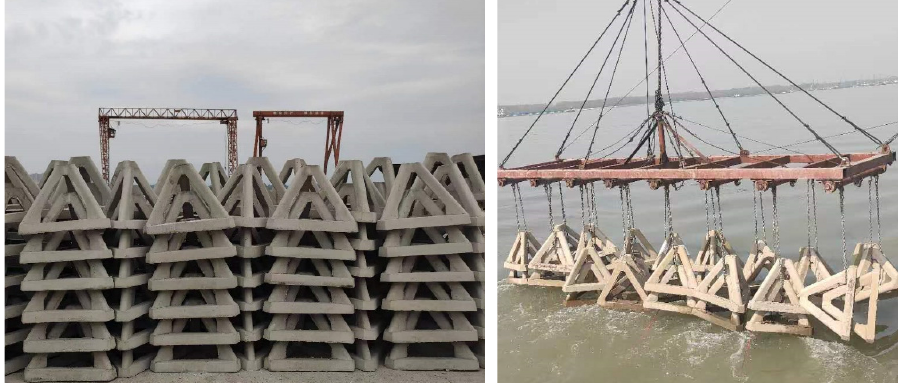
Figure 12. Batch production and dropped into the river.